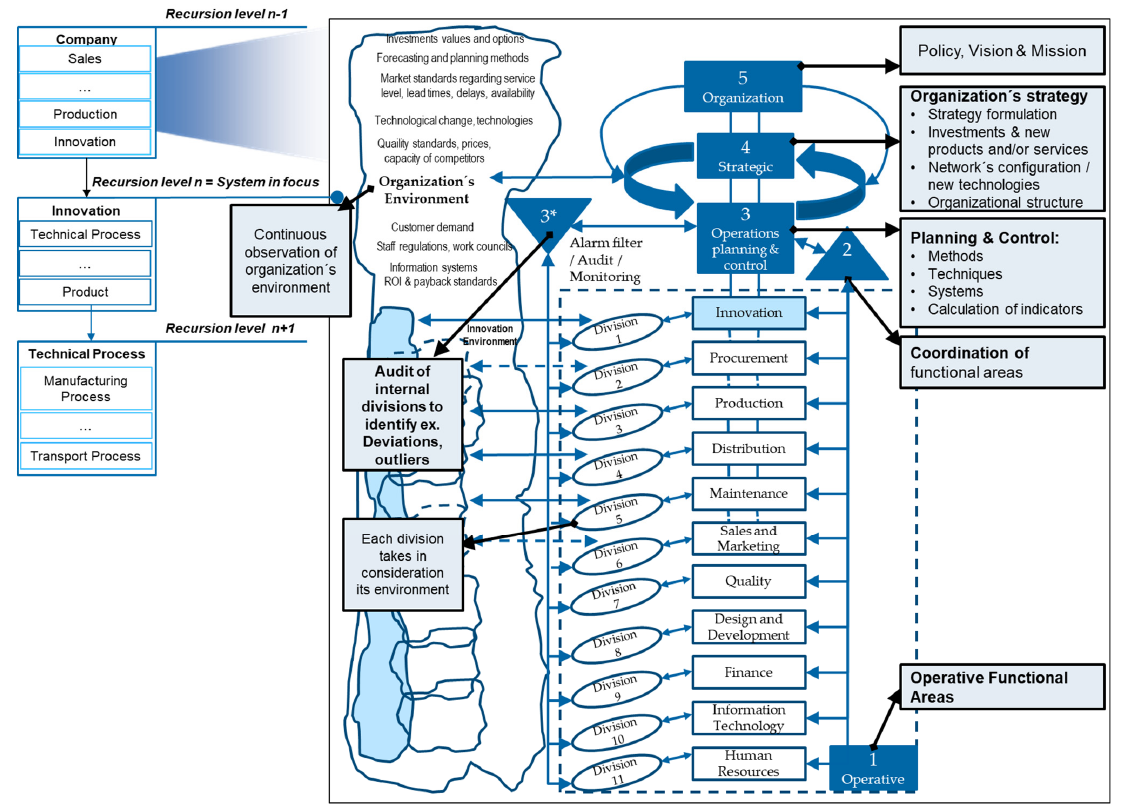
Figure 3. VSM recursion level for the company (own elaboration based on [44–46].